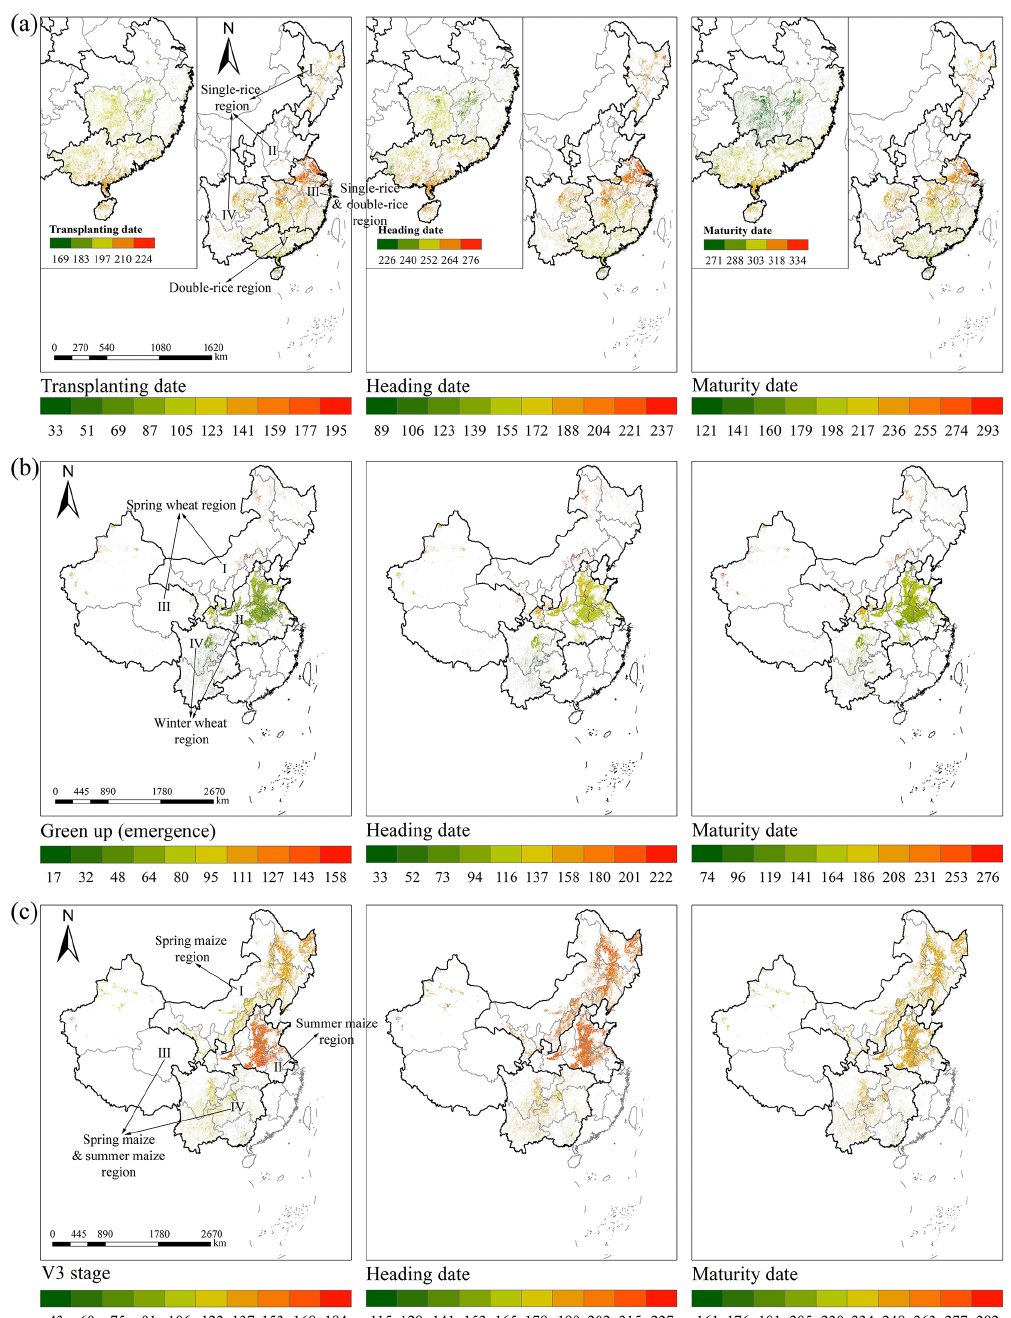
Figure 6. Spatial patterns of annual averages of three key phenological dates during 2000–2015 for rice (a) , wheat (b) and maize (c)